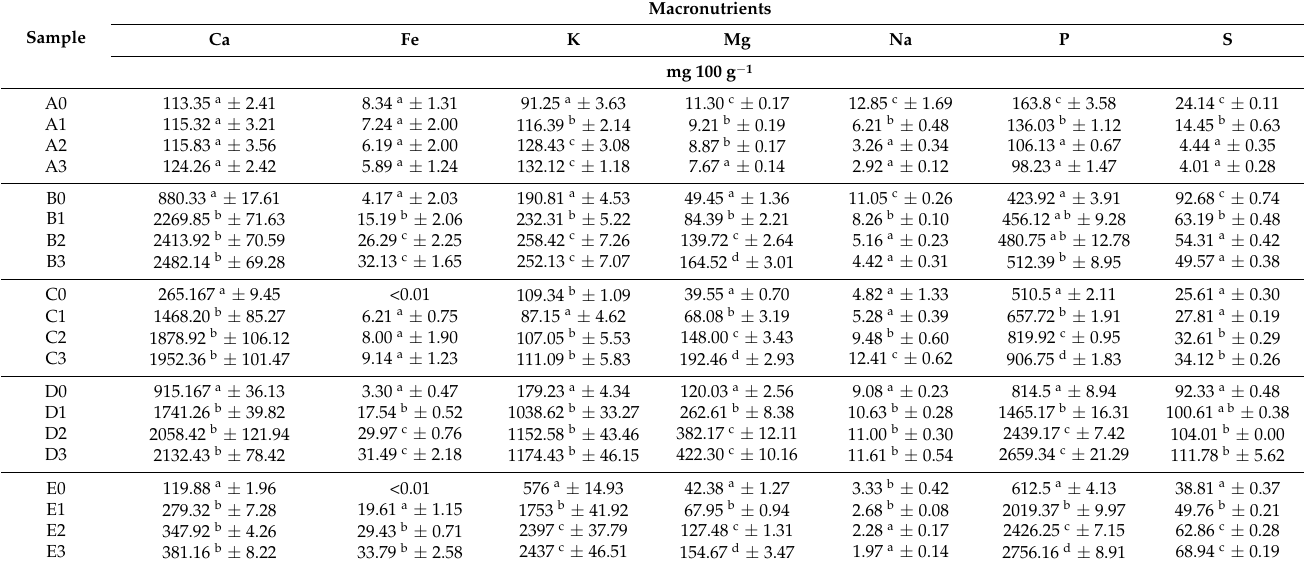
Table 5. Content of selected macronutrients in oak biomass and its biochars.